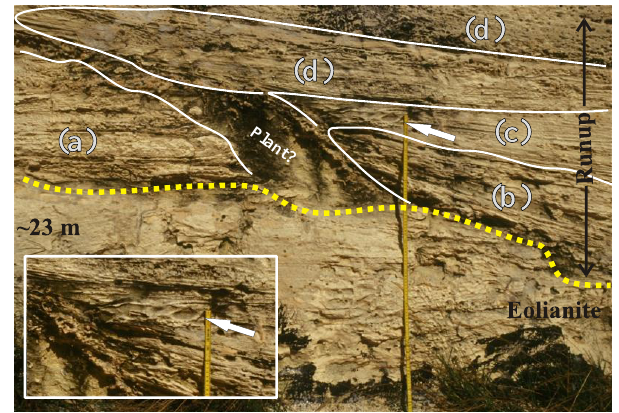
Figure 23. Photograph of runup deposits in a road cutting above + 23m (1m scale in photo) on Old Land Road, Great Exuma Island, situated deep in Exuma Sound ∼ 200km south of North Eleuthera. The older built-up eolianite forms the lower half of the image; the upper half has multiple “packages” of planar, fenestrae-filled beach sets. The upper progression of sedimentary packages (labeled a– e ) clearly shows an onlapping, rising sequence of beds, indicating increasing wave energy and degree of runup. Further, the individ- ual laminae of scour structures (arrows and inset image) display the same onlapping, upward-climbing succession. It would be im- possible to achieve such bedding if rain-saturated sediments were sloughing downhill on low-angle slopes under the influence of grav- ity, especially near the crest of a